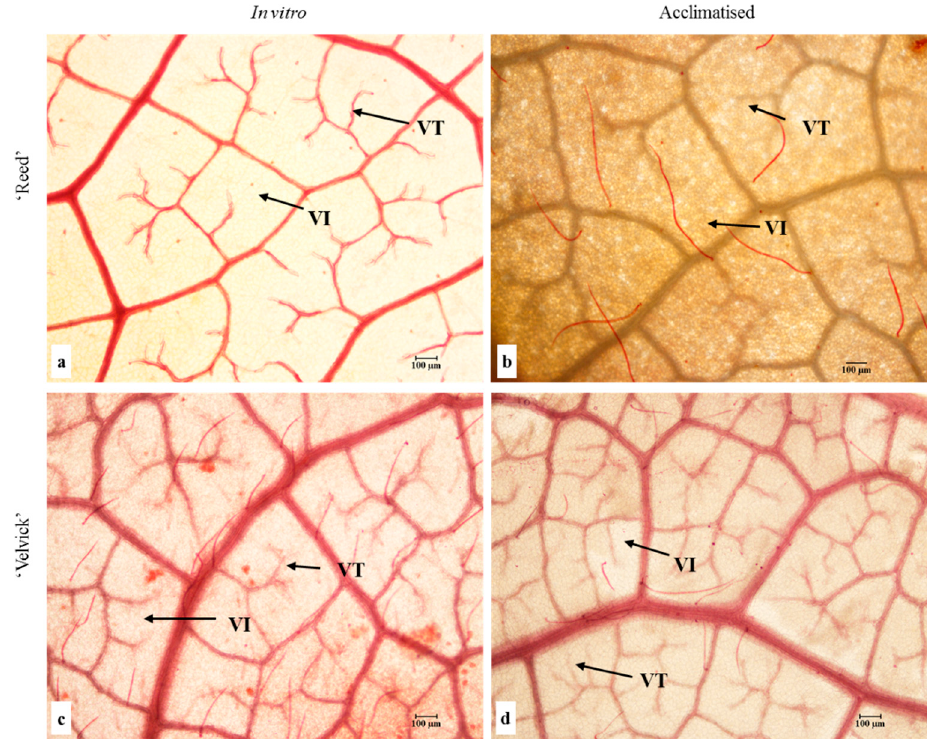
Figure 8. Leaf vein architecture of in vitro ( a , c ) and acclimated ( b , d ) tissue culture plantlets of ‘Reed’ ( a , b ) and ‘Velvick’ ( c , d ). Trichomes are also stained in red. VI = vein-islet (smallest area of photosynthetic tissue surrounded by conducting strands) and VT = vein termination were observed in tissues fixed in a 1:1:3 ( v : v ) solution of formalin, acetic acid and ethanol, bleached in NaOH and cleared with chloral hydrate.